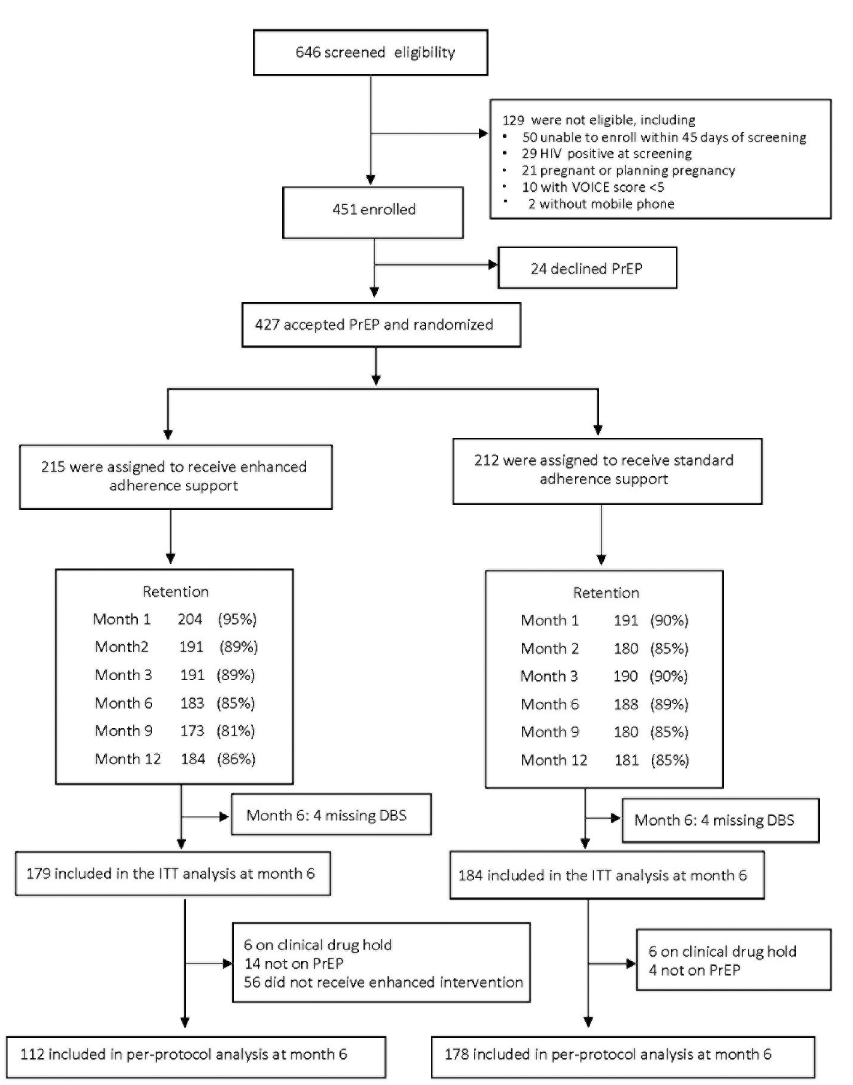
Fig 2. Participant flowchart diagram for HPTN 082. DBS, dried blood spots; HPTN, HIV Prevention Trials Network; ITT, intention-to-treat; PrEP, pre-exposure